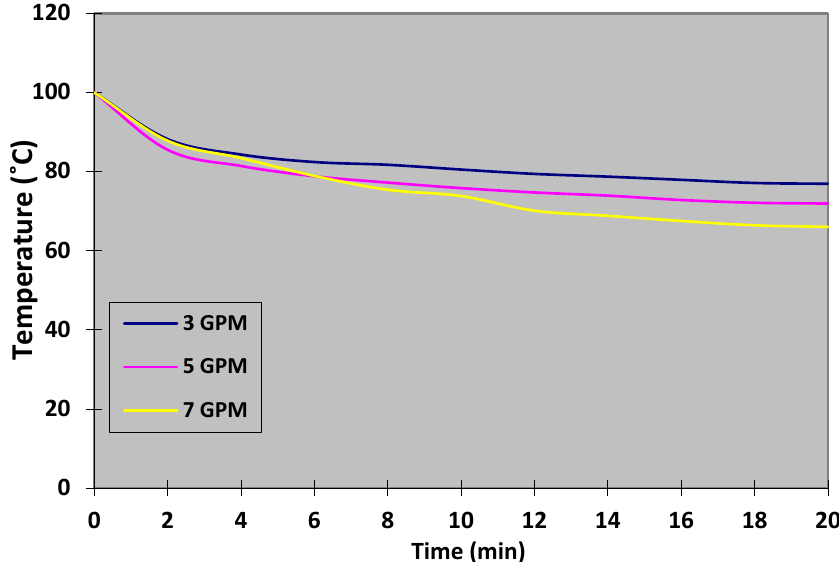
Figure 10. Surface temperature for 100% of ethylene glycol.